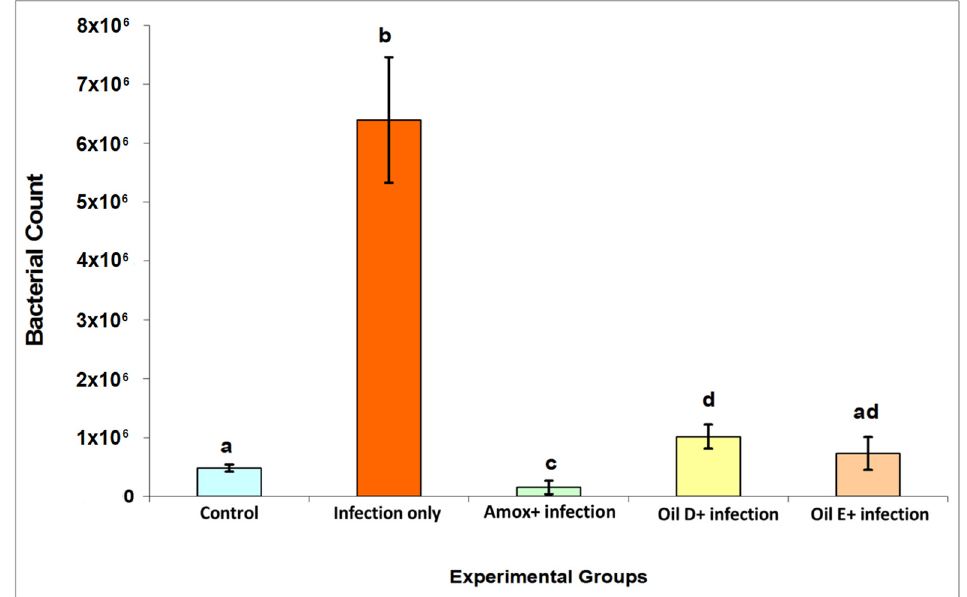
Figure 2. C. perfringens count was recovered from the intestinal contents of the birds with and without NE. All the control groups reflect the basal bacterial counts in the presence of intestinal stressors (nutritional and coccidial overdose vaccination) in the untreated nonexperimentally infected birds. The values are means ± S.E. Different letters represent statistically significant differences with a p-value less than 0.05.